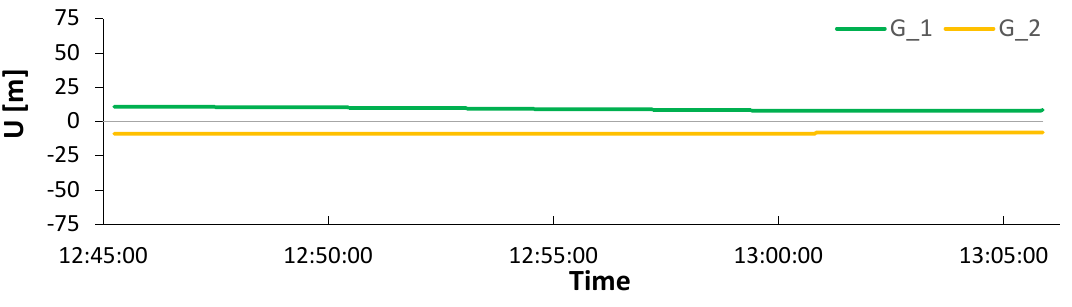
Figure 7. Plot of U-component deviations of point measurements with code receivers.